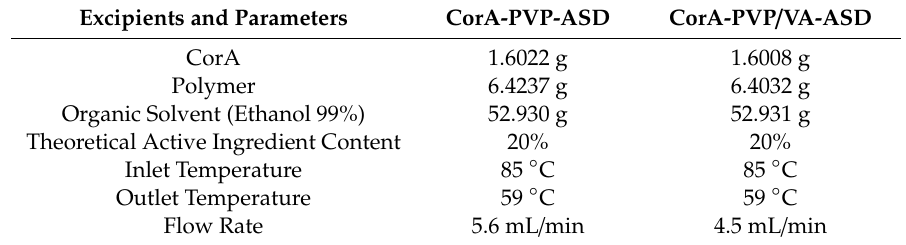
Table 1. CorA-amorphous solid dispersion (ASD) formulation excipients and process